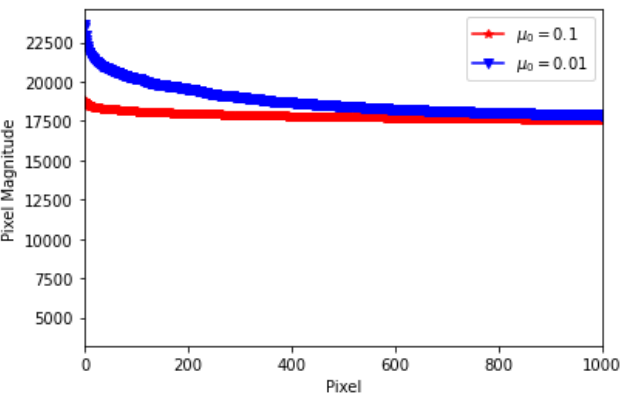
Figure 7. Rate of decay of coefficients, zoomed in towards the higher magnification coefficients to view the difference between µ 0 = 0.1 and µ 0 =